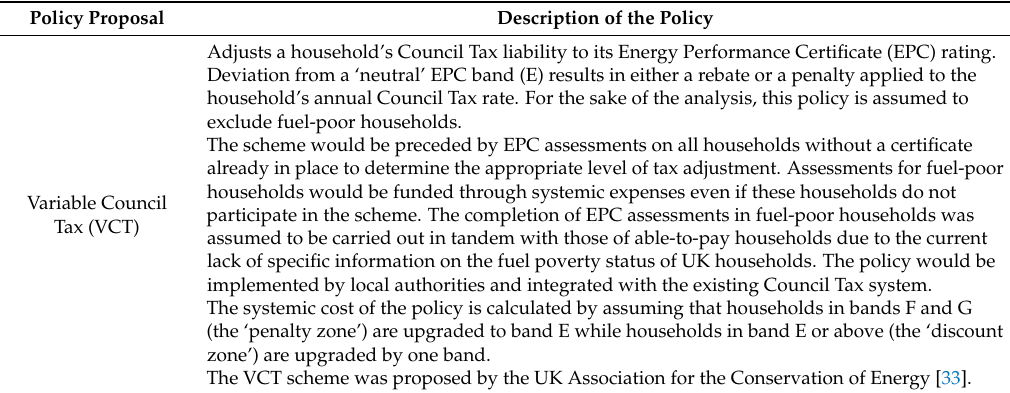
Table 1. Policy proposals chosen for